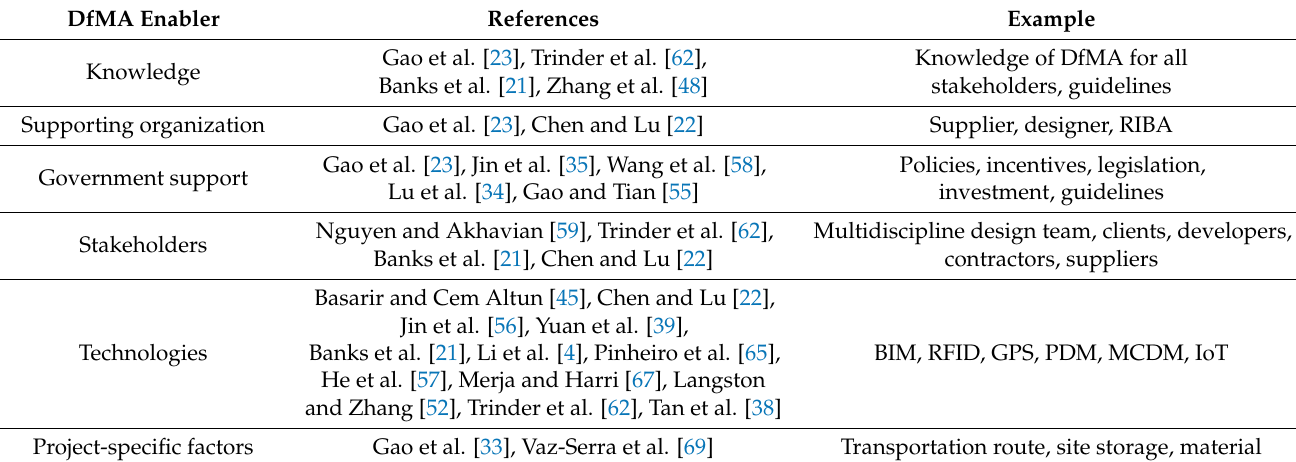
Table 4. Summary of enablers for DfMA/prefabrication